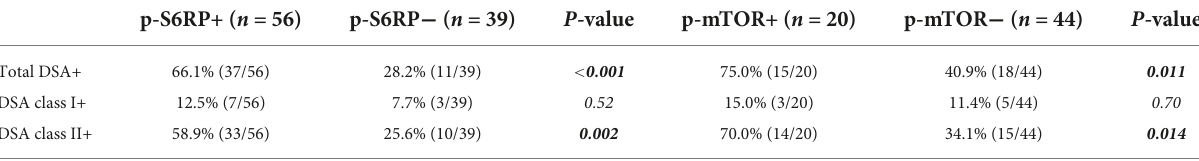
TABLE 5 Percentage of positive and negative p-S6RP and p-mTOR staining in peritubular capillaries in biopsy cases with class I, class II, and total